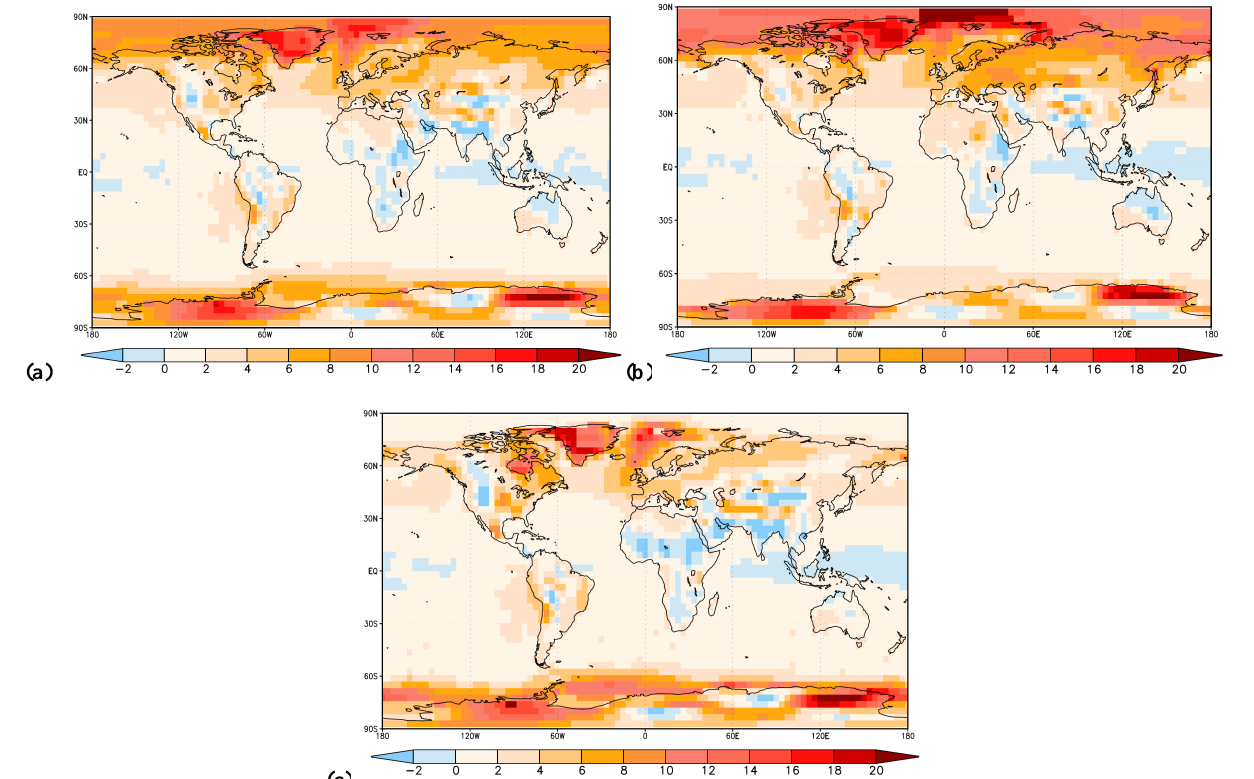
Fig. 8. Anomalies of SAT in ◦ C between the mid-Pliocene and PI control runs of experiment 1. Shown are annual mean (a) , boreal winter season (DJF) (b) , and boreal summer season (JJA) (c) , retrieved from a 30-yr climatology. Strong temperature anomalies over the Hudson Bay are caused by the change in the land-sea